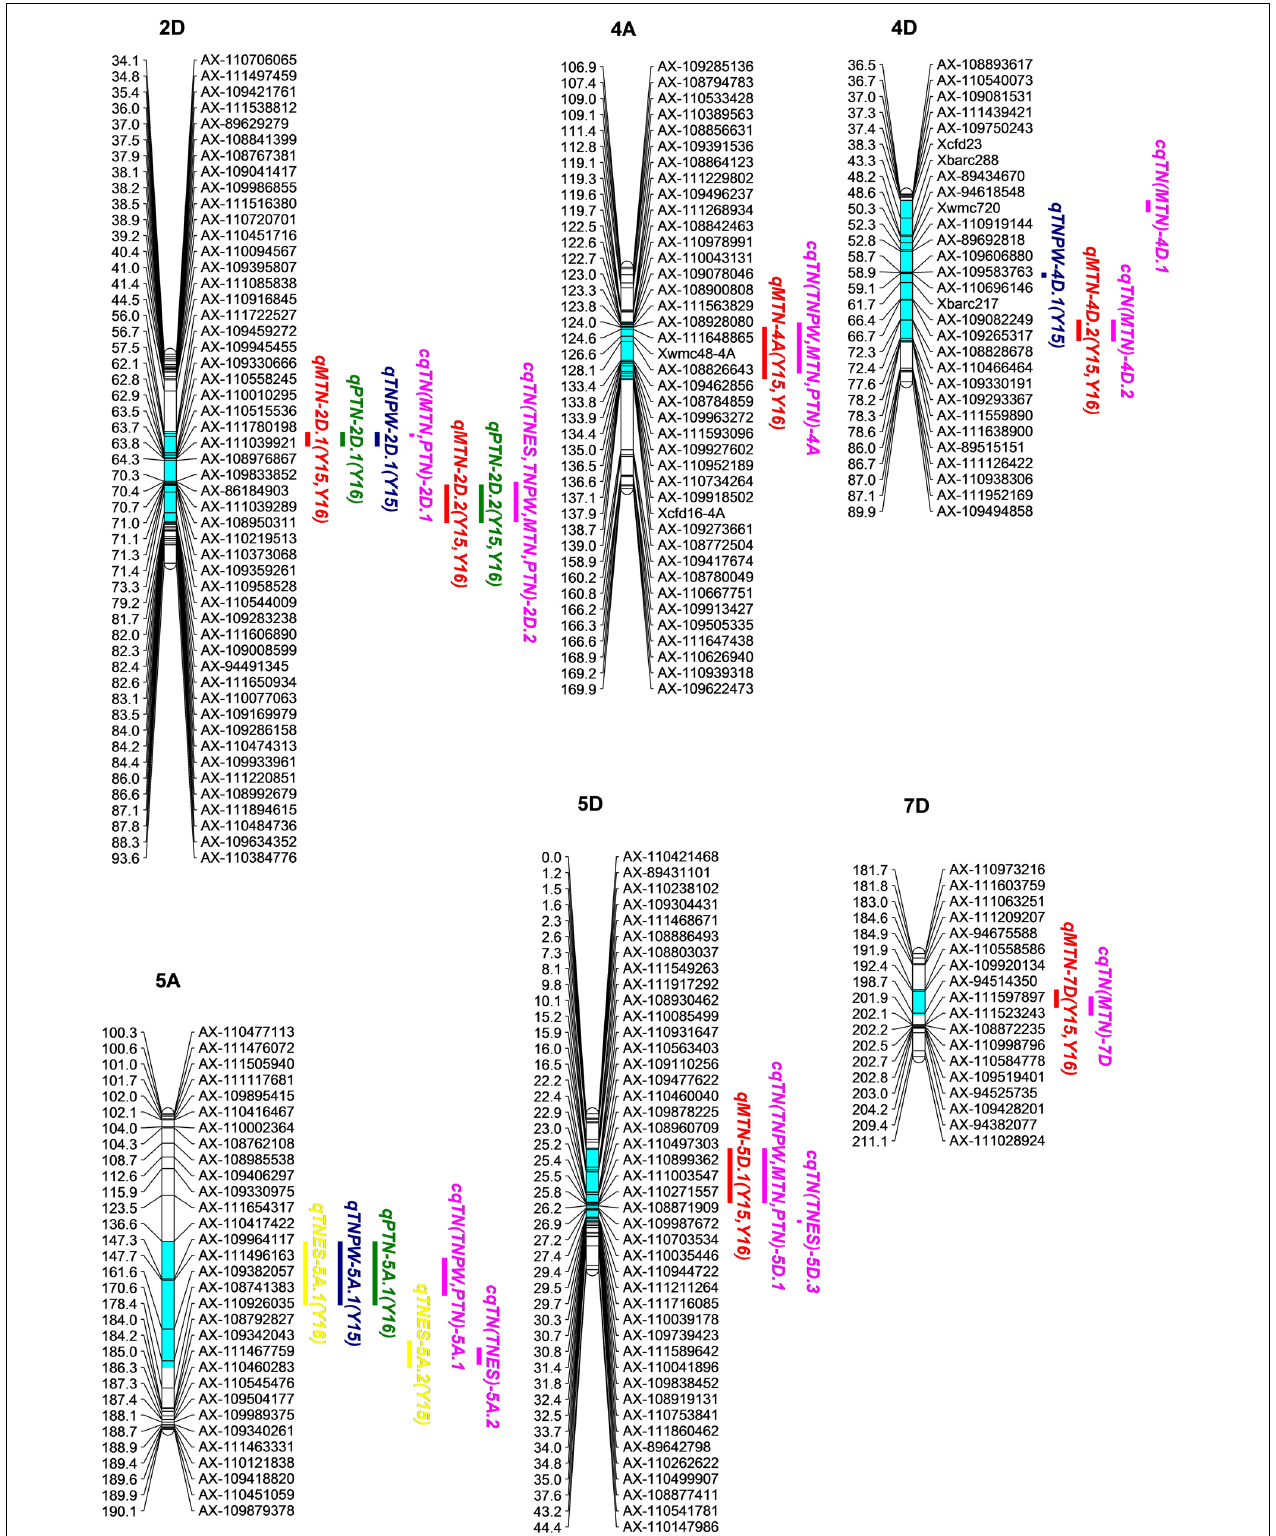
FIGURE 1 | Chromosomal locations of the seven stable QTL associated with TNES, TNPW, MTN, and PTN based on a 371 RIL population derived from a across between CN18 and T1208. QTL intervals were determined by LOD-2 from the peak. The putative QTL clusters were marked clearly on the chromosomes.